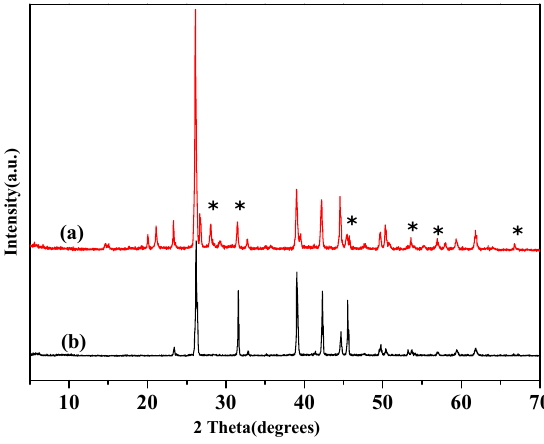
Figure 6. XRD analyses of ( a ) the exchange solvent, after separation and washing; ( b ) NaBF 4 . The obtained salt reflection was marked with a star and was consistent with NaCl.